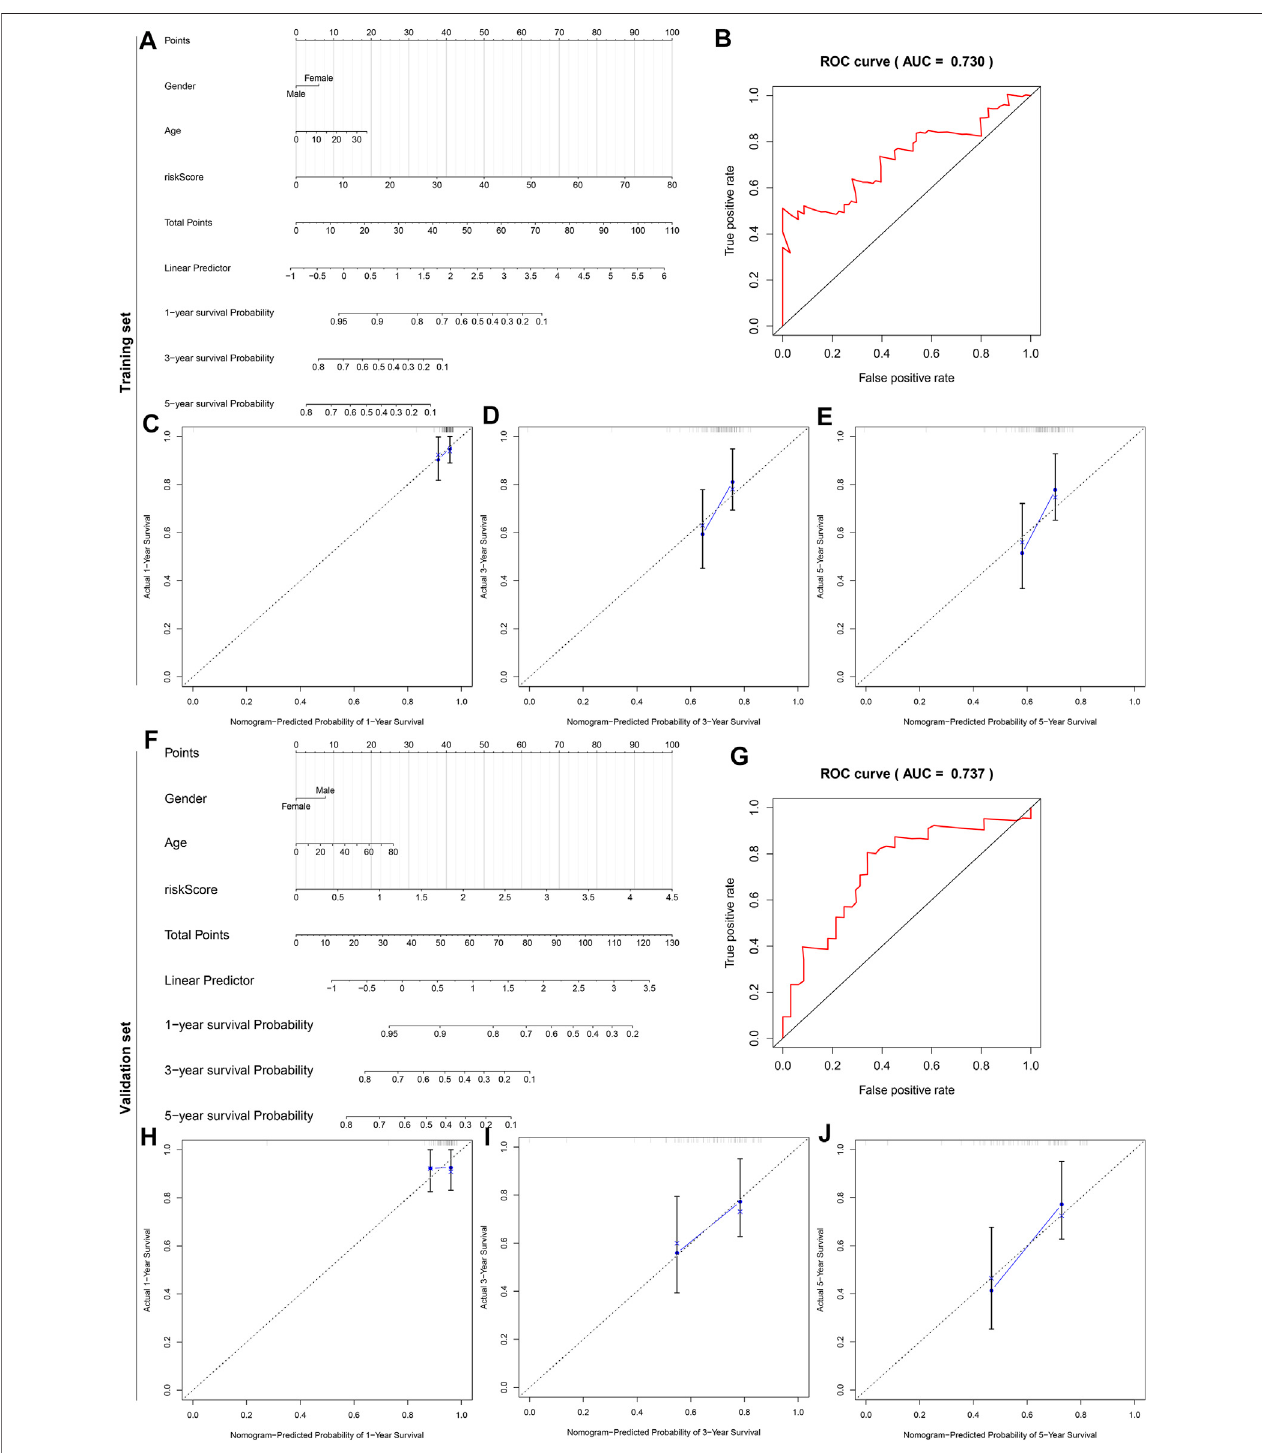
FIGURE 10 | A nomogram for prediction of osteosarcoma patients ’ prognosis. (A) A nomogram combining gender, age, and risk score for determining the 1-, 3-, and 5-years survival probability of osteosarcoma patients in the TARGET cohort. (B) The time-dependent ROC curves of this nomogram for overall survival of osteosarcoma patients. (C – E) The calibration plots of the nomogram for prediction of survival probability at 1, 3, and 5 years. The x -axis indicates the nomogram- predicted probability, and the y -axis indicates the actual survival. (F) External veri fi cation ofthe prognostic ef fi cacyofthisnomogramin predicting the 1-,3-, and 5- yearssurvivalprobabilityofosteosarcomapatientsintheGSE21257cohort. (G) Thetime-dependentROCcurvesofthenomogramfor1-,3-,and5-yearssurvival. (H – J) The calibration curves for the nomogram at 1, 3, and 5 years.